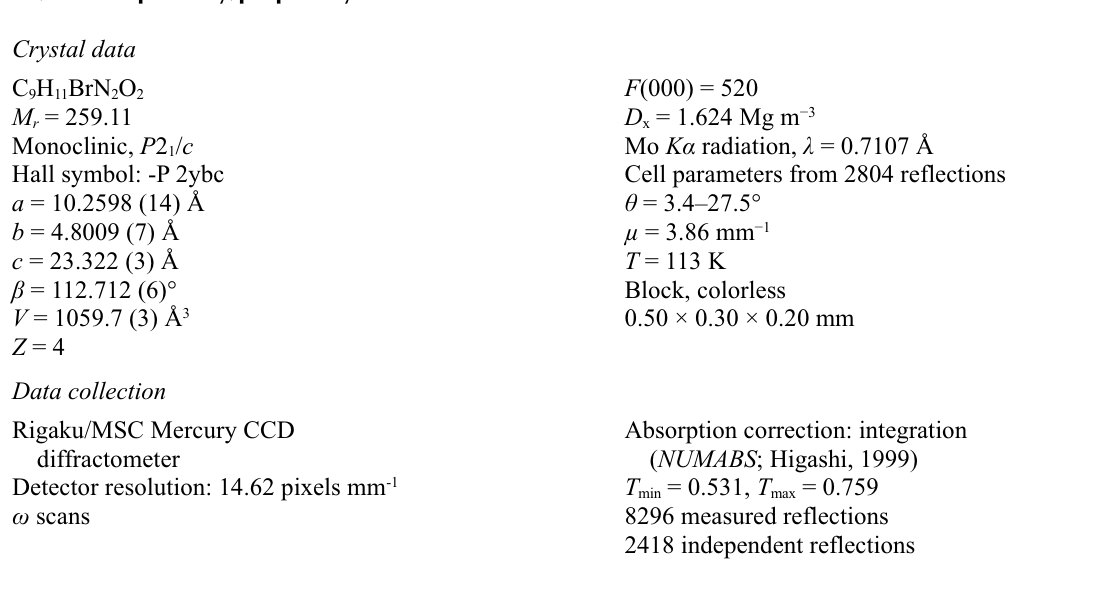
View of the N—H···O hydrogen bonded molecules. The unit cell has been omitted for clarity.